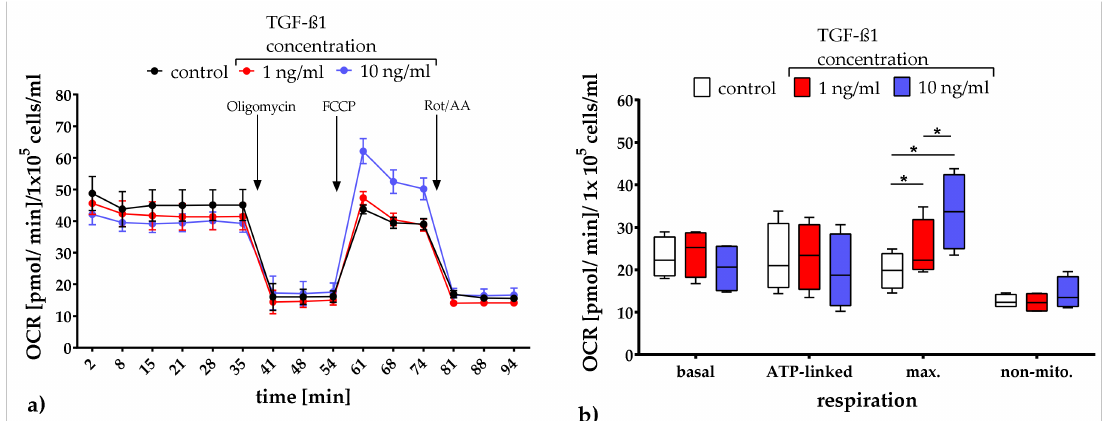
Figure 2. Quantification of the oxygen consumption rate (OCR) after TGF-ß1 exposure on day 3. OCR data presented as mean with the standard error of the mean normalized to 1 × 10 5 cells / ml ( a ). Corresponding to their function in the respiratory chain, the numerical data were presented as box plots, with medians, interquartile ranges and minimum / maximum values ( b ). Since the dataset did not represent a Gaussian distribution (Shapiro-Wilk test), the statistical analysis was performed using the Two-Way ANOVA test followed by Tukey’s multiple comparison post hoc test ( n = 4). * p ≤ 0.05. Comparison with the control. FCCP: carbonyl-cyanide-4 (trifluoromethoxy) phenylhydrazone; Rot / AA: rotenone / antimycin A; ATP: adenosine triphosphate; max.: maximal; non-mito.: